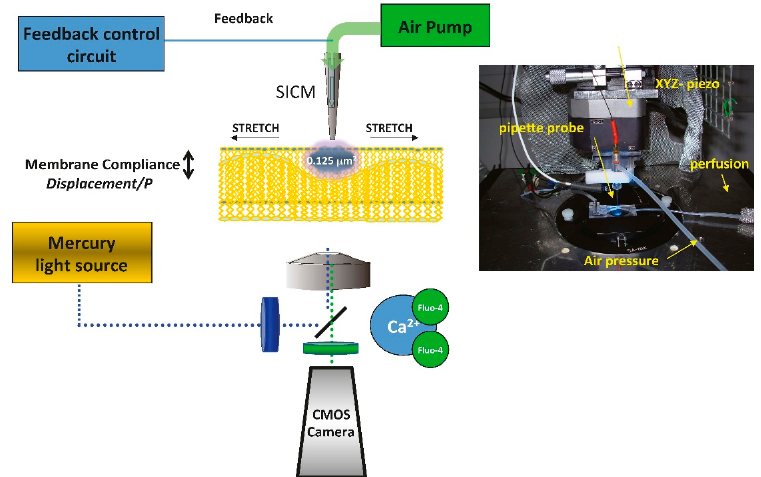
Figure 2. Schematic representation of nanoscopic technology for interrogates subsarcolemmal mitochondrial mechanosensitivty. Blue dotted line: excitation light. Green dotted line: emission light from the sample.